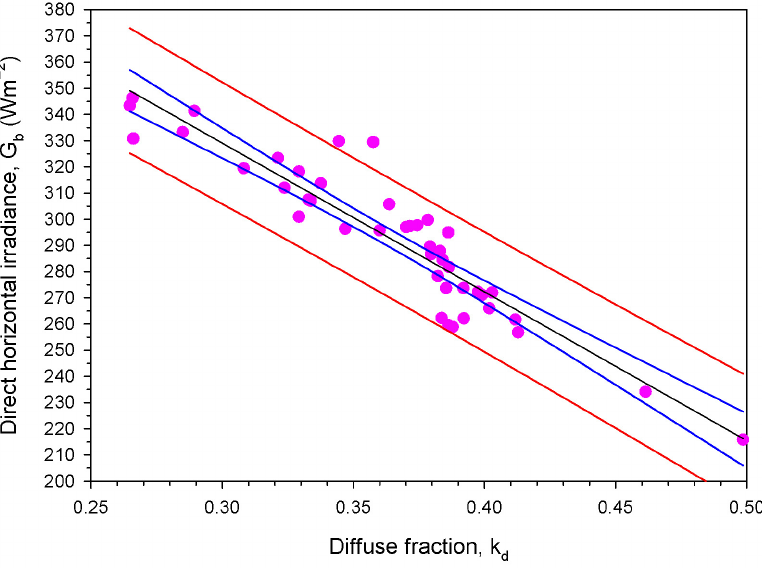
Figure 6. Scatter plot of the annual mean values of G b for the 43 sites as a function of their k d under all-sky conditions in Saudi Arabia over the period 2013–2021. The black line is a linear fit to the data points with equation G b = − 568.2313k d + 499.5480 with RMSE = 417.1854 Wm − 2 , MAE = 413.5269 Wm − 2 , d = 0.9610, r = − 0.9276, and R 2 = 0.8605. The blue band represents the ± 95% confidence interval, and the red one represents the ± 95% prediction interval. The plot was made with the SYSTAT’s SigmaPlot 14.0.0.124 graphing software and the statistical results were computed with the MICROSOFT’s Excel 2021 functions.